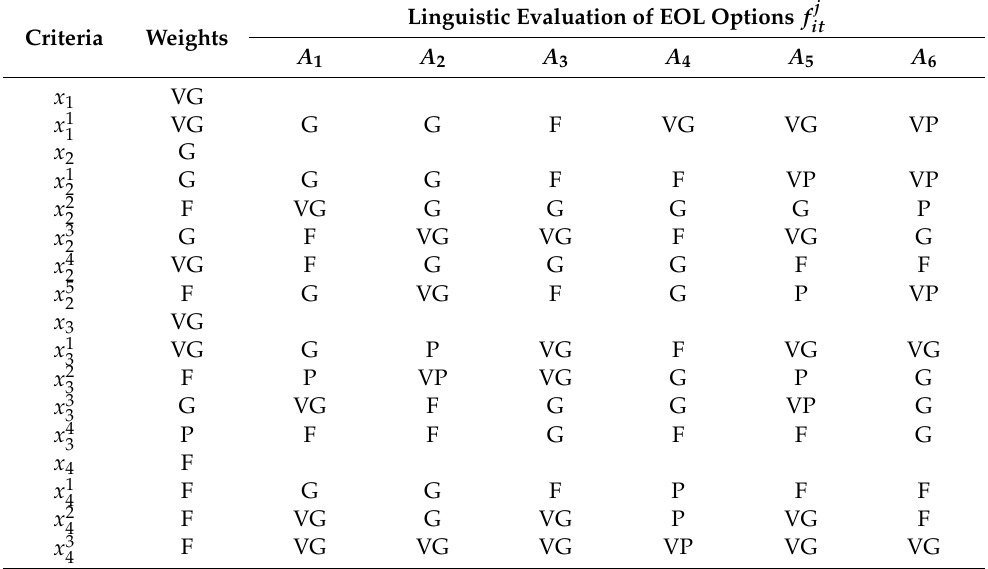
Table 2. Criteria importance and EOL options for linguistic evaluation with respect to cabinet